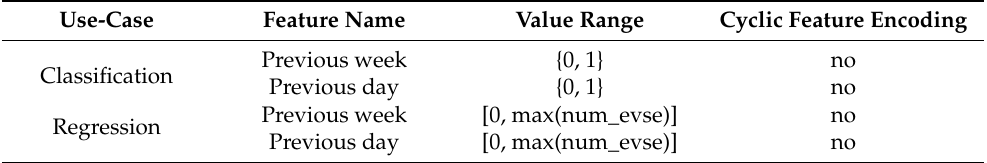
Table 2. Feature description for additional features in augmented feature